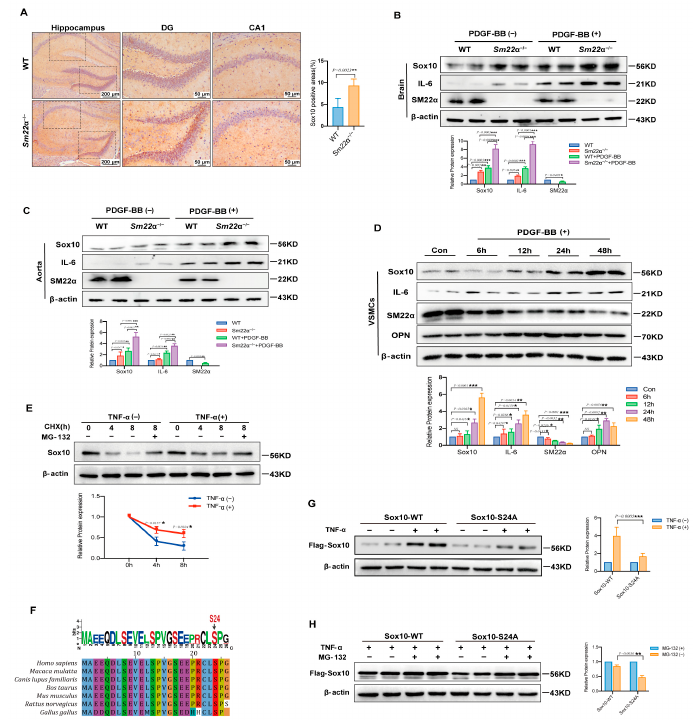
Figure 6. Sox10 expression is associated with the inflammatory response in the mouse brain. ( A ) Representative images of Sox10 immunohistochemical staining in the hippocampus of the WT and Sm22 α − / − mice are shown on the left, with the corresponding statistical result on the right. ( B ) Representative Western blots and quantitative analysis of the brain in the WT and Sm22 α − / − mice treated with PDGF-BB ex vivo. ( C ) Representative Western blots and quantitative analysis of the aorta in the WT and Sm22 α − / − mice treated with PDGF-BB ex vivo. ( D ) Representative Western blots and quantitative analysis of VSMCs treated with PDGF-BB at different time points. ( E ) Representative Western blots and quantitative analysis of Sox10 in HEK 293A cells treated with TNF- α after pretreatment with CHX or MG132 for the indicated times. ( F ) Sequence alignment of Sox10 Ser24 from different species. ( G ) Representative Western blots and quantitative analysis of Sox10 in HEK 293A cells trans- fected with Flag-Sox10-WT or Flag-Sox10-S24A, and then treated with TNF- α . ( H ) Representative Western blots and quantitative analysis of Sox10 in HEK 293A cells transfected with Flag-Sox10-WT or Flag-Sox10-S24A, and then pretreatment with or without MG132 before adding TNF- α . Data are represented as the mean ± SD. * p < 0.05, ** p < 0.01, and *** p < 0.001. Sox10 is tightly regulated at the post-translational level. To determine whether protein stability contributes to increased Sox10 expression in the context of inflammatory